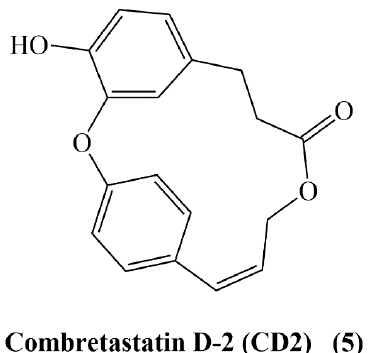
Figure 1. Structures of combretastatins.